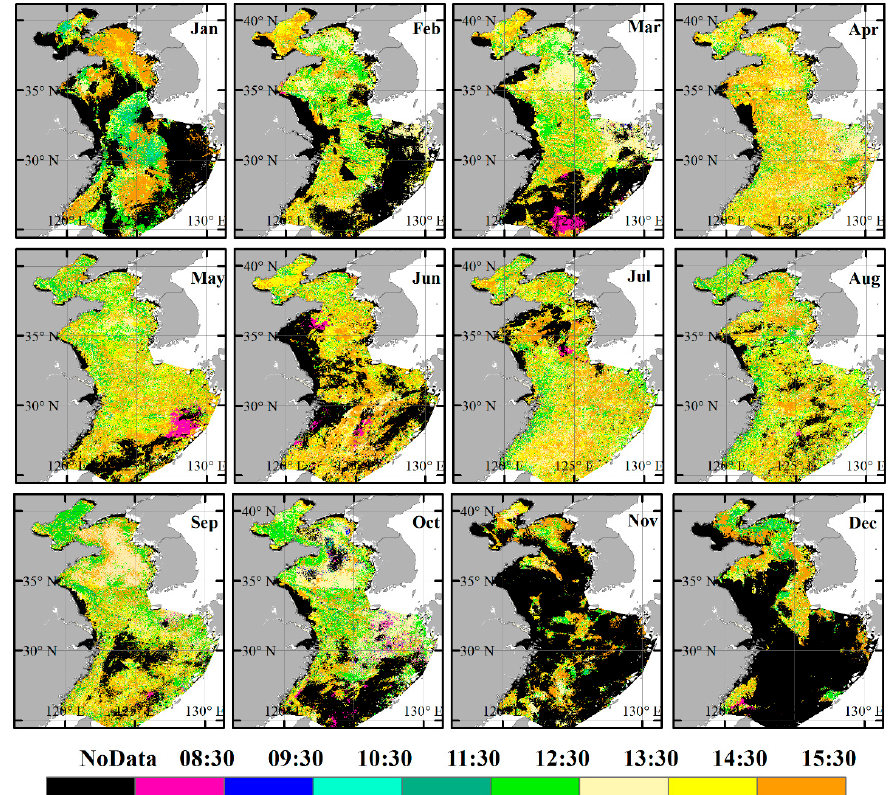
Figure 18. Hours corresponding to minimum TSS sampling bias. The results were calculated based on days with eight observations from GOCI (2013–2017). The black color denotes regions with inadequate data during calculations. Table 6. Hours corresponding to minimum TSS sampling bias and cloud coverage for each